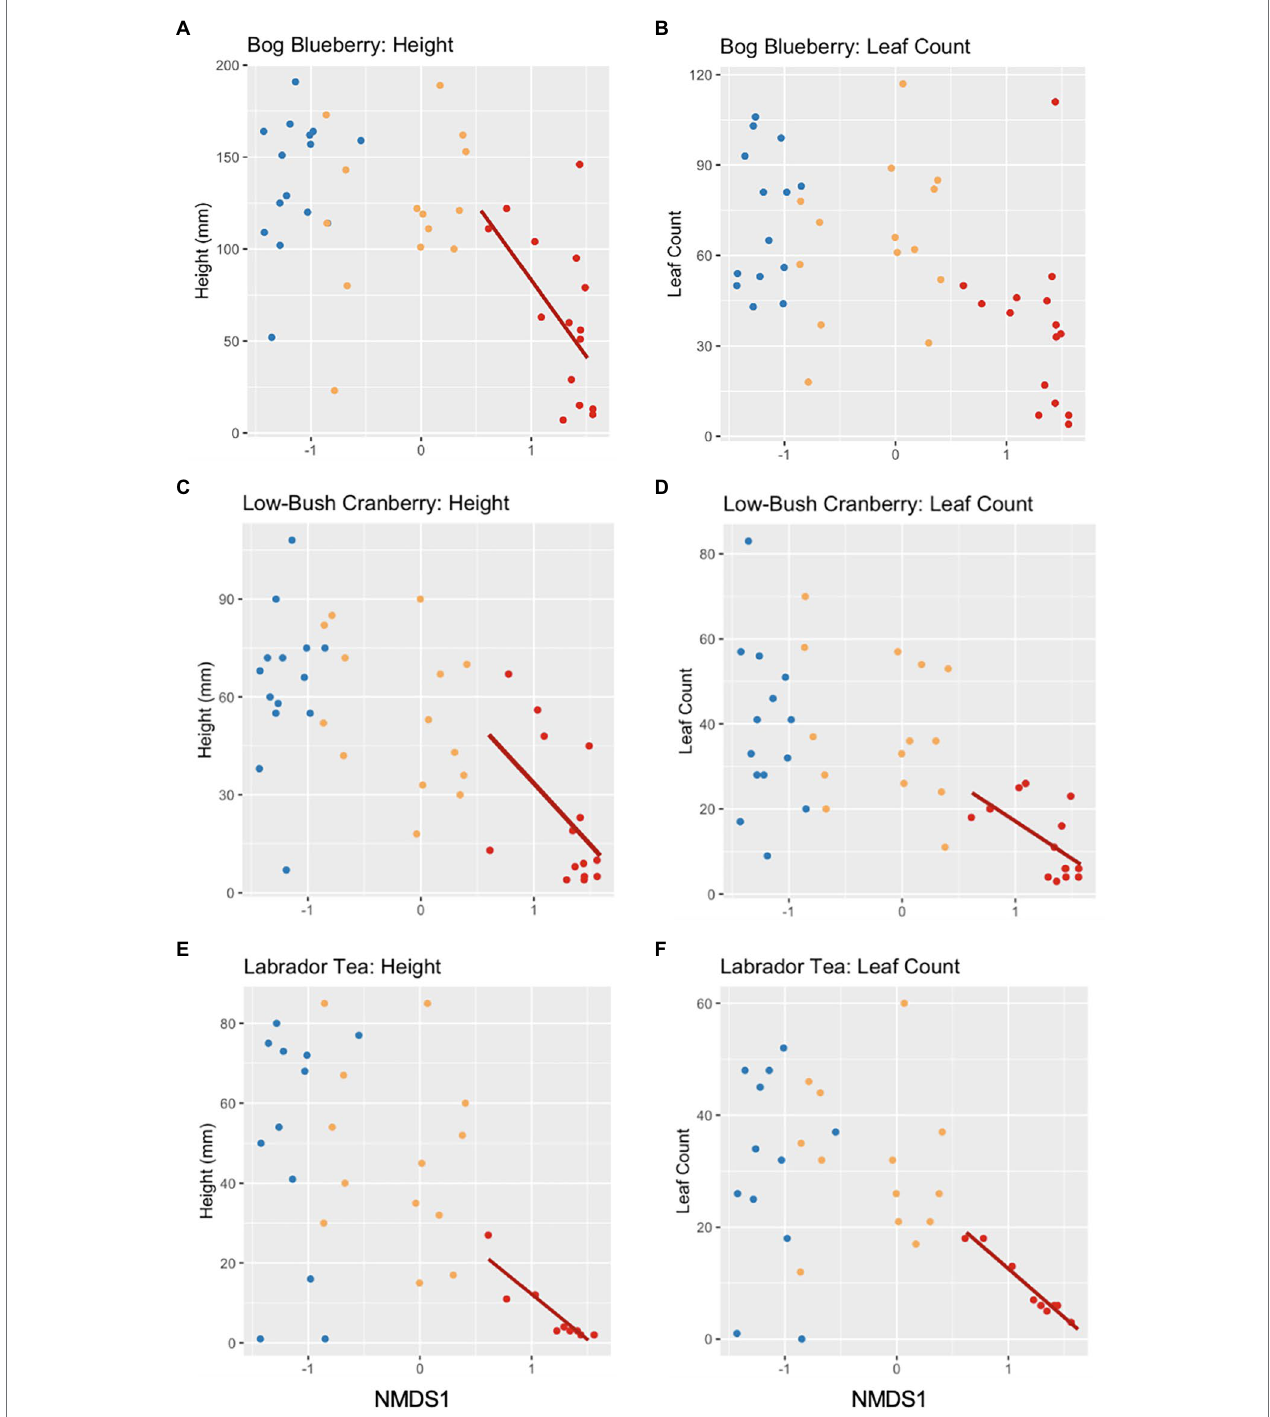
FIGURE 4 | Scatterplots showing the effects of microbial community variation and plant productivity (16S rRNA amplicon NMDS1 and height/leaf count) of bog blueberry (A,B) , low-bush cranberry (C,D) , and Labrador tea (E,F) . Each point represents a soil community, colored by the level of FPES soil disturbance with blue = undisturbed (UD; n = 16), gold = semi disturbed (SD; n = 15), and red = most disturbed (MD; n = 16). Solid lines represent a significant linear